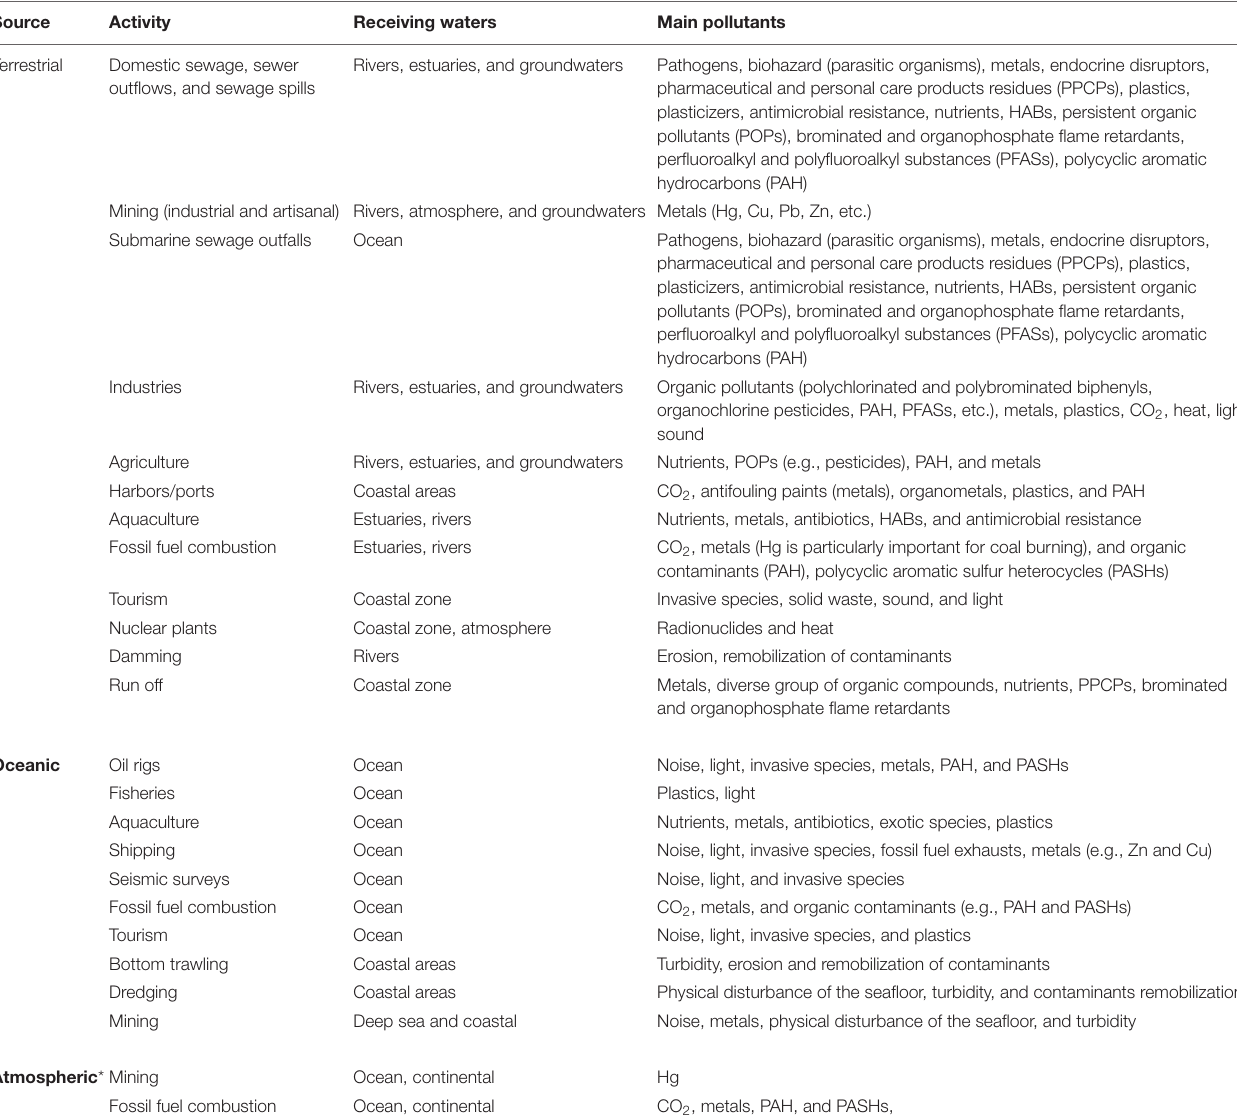
TABLE 3 | Pressing anthropogenic drivers and associated pollutants for the coastal ecosystems and the South Atlantic